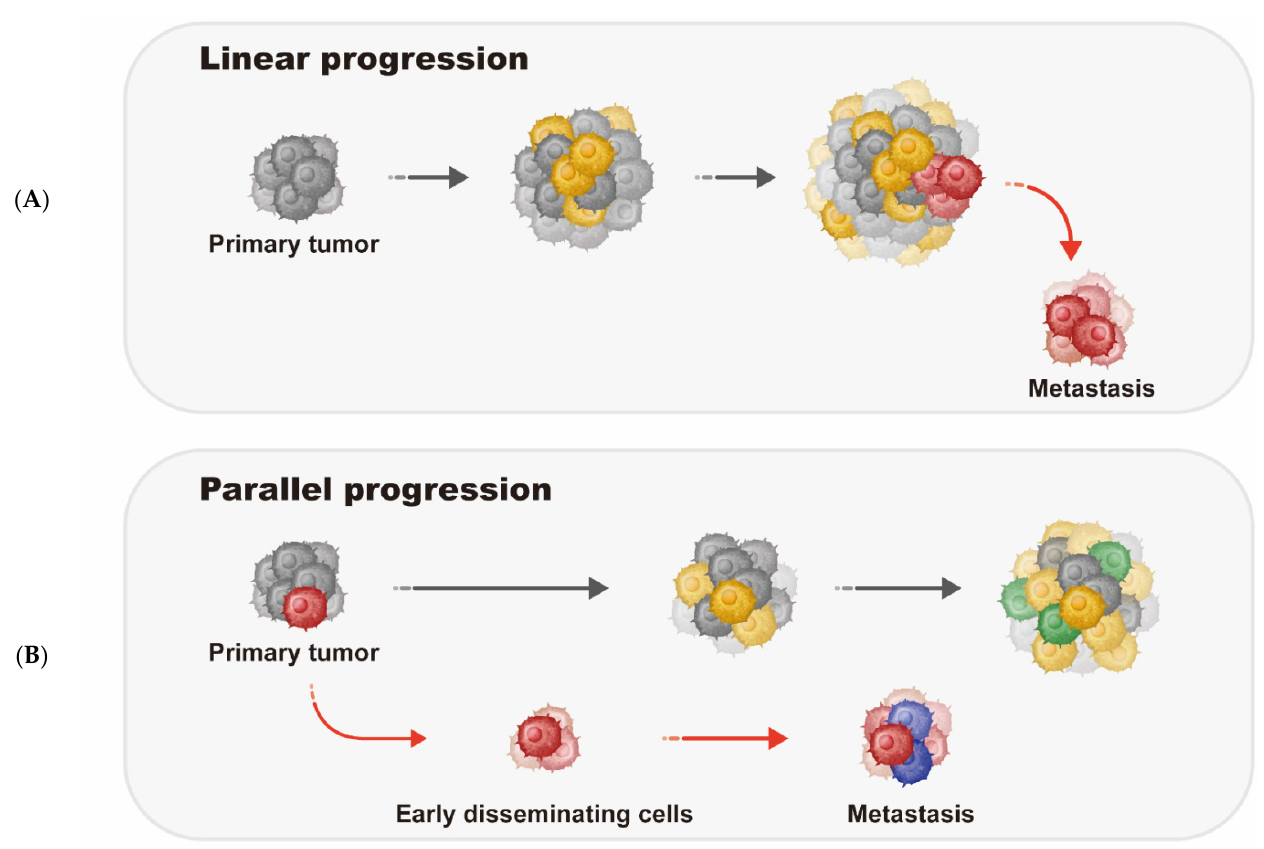
Figure 1. Models of cancer metastasis. Two models of cancer metastasis have been proposed: the linear model ( A ) and the parallel model ( B ). In the linear model, metastatic clones arise late in the evolution of the primary tumor when they are equipped with all the necessary properties to disseminate and successfully colonize a secondary site ( A ). In contrast, in the parallel model, metastatic clones escape from the primary tumor early and evolve separately and eventually forming metastasis ( B ).